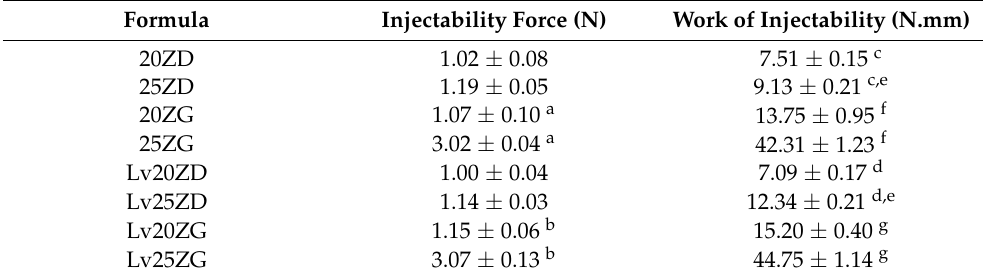
Table 2. Injectability properties of zein-loaded ISG formulations ( n = 3).